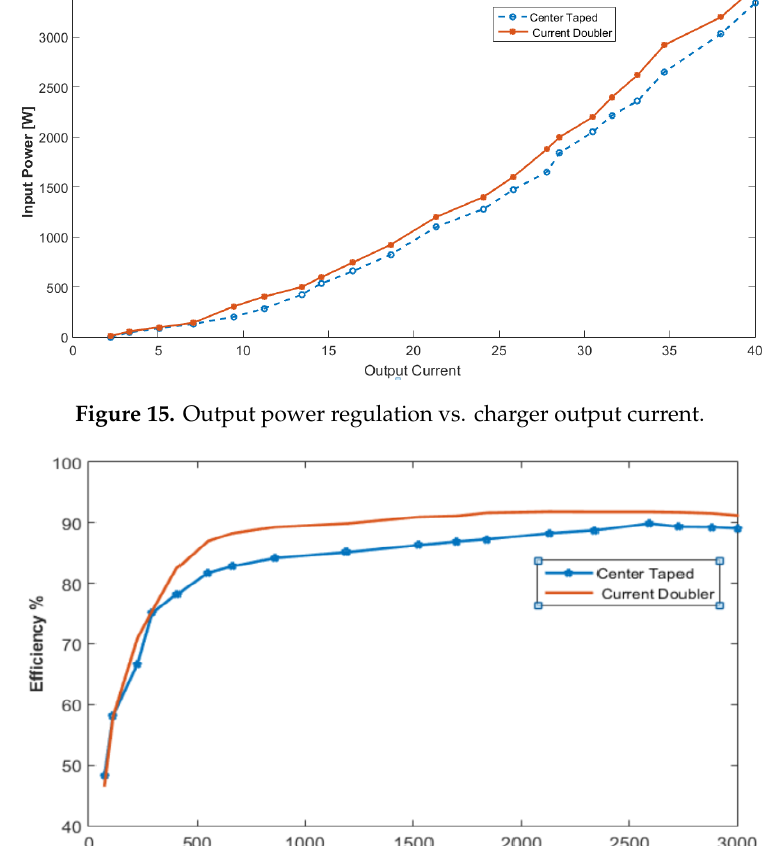
Figure 14. Comparison of conduction losses with switching losses.